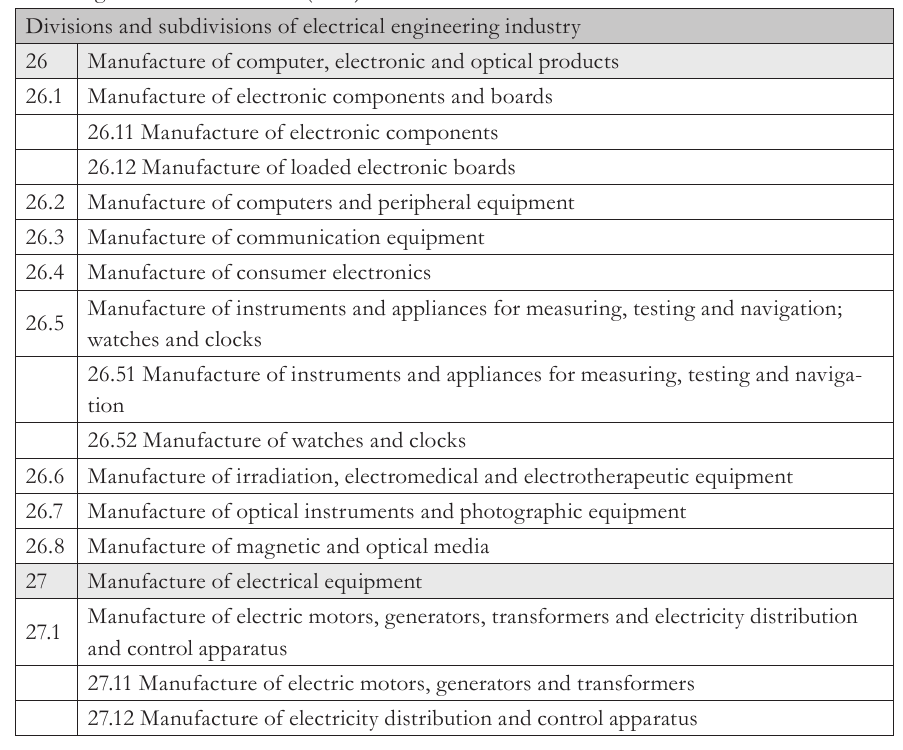
Tab. 1 – Divisions and subdivisions of electrical engineering industry. Source: own